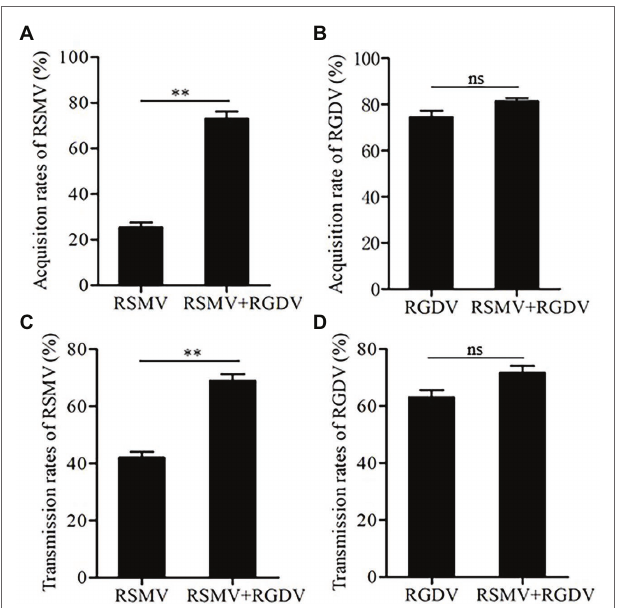
FIGURE 5 | The acquisition and transmission rates of RSMV and RGDV by R. dorsalis. (A) The acquisition rates of RSMV by R. dorsalis fed on rice plants singly infected with RSMV or co-infected with RSMV and RGDV for 2 days. (B) The acquisition rates of RGDV by R. dorsalis fed on rice plants singly infected with RGDV or co-infected with RSMV and RGDV for 2 days. (C) The transmission rates of RSMV by R. dorsalis singly infected with RSMV or co- infected with RSMV and RGDV. (D) The transmission rates of RGDV by R. dorsalis singly infected with RGDV or co-infected with RSMV and RGDV. Means (±SD) from three biological replicates are shown. ** p < .01. ns, not significant.